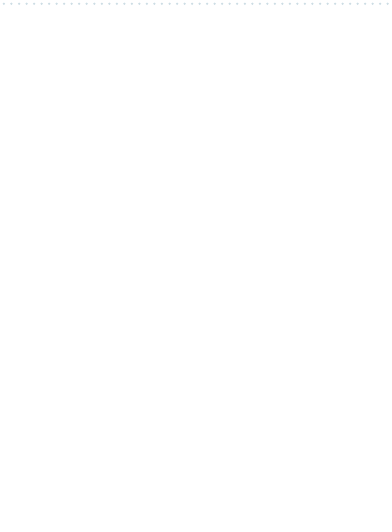
Figure 5. The influence of asymmetry degrees N 1 , N 2 , N 3 on the ( a ) upper and lower edge frequencies and ( b ) relative bandwidth of the single-mode areas.